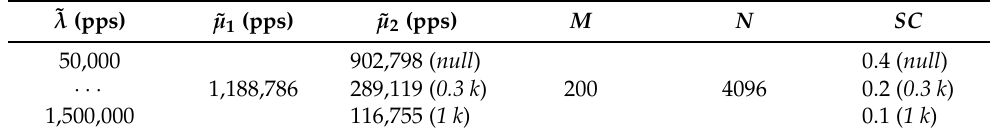
Table 1. Set of values for the input parameters of the numerical evaluation. ˜ λ (pps) ˜ µ 1 (pps) ˜ µ 2